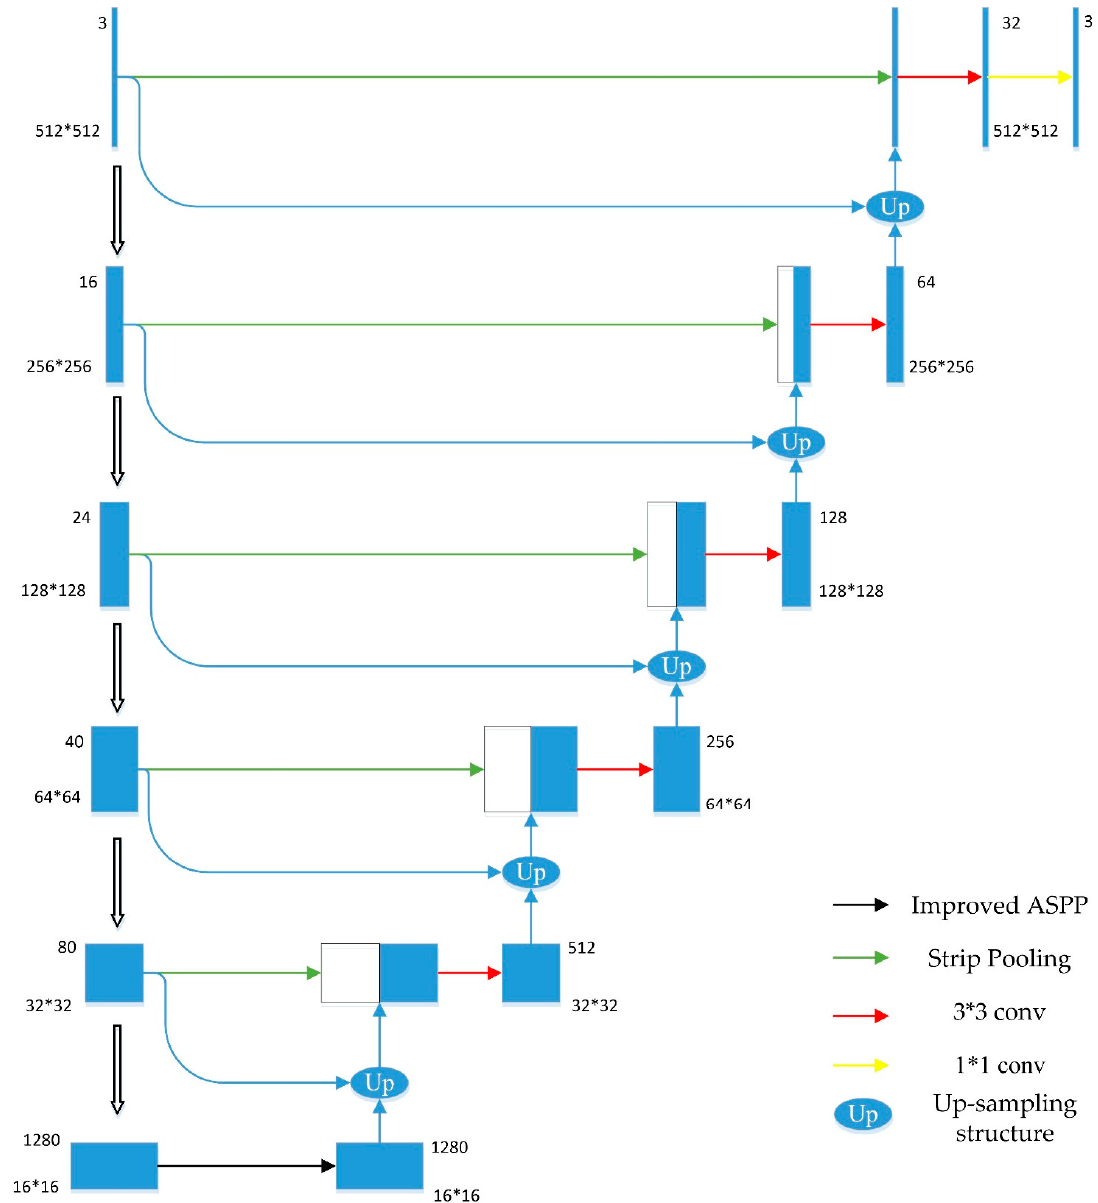
Figure 2. The improved U-Net model. Each blue rectangle represents a multi-channel feature map, and the white rectangle represents the feature map obtained by bar pooling. The number of channels is at the top of the rectangle, and the size is at the bottom.